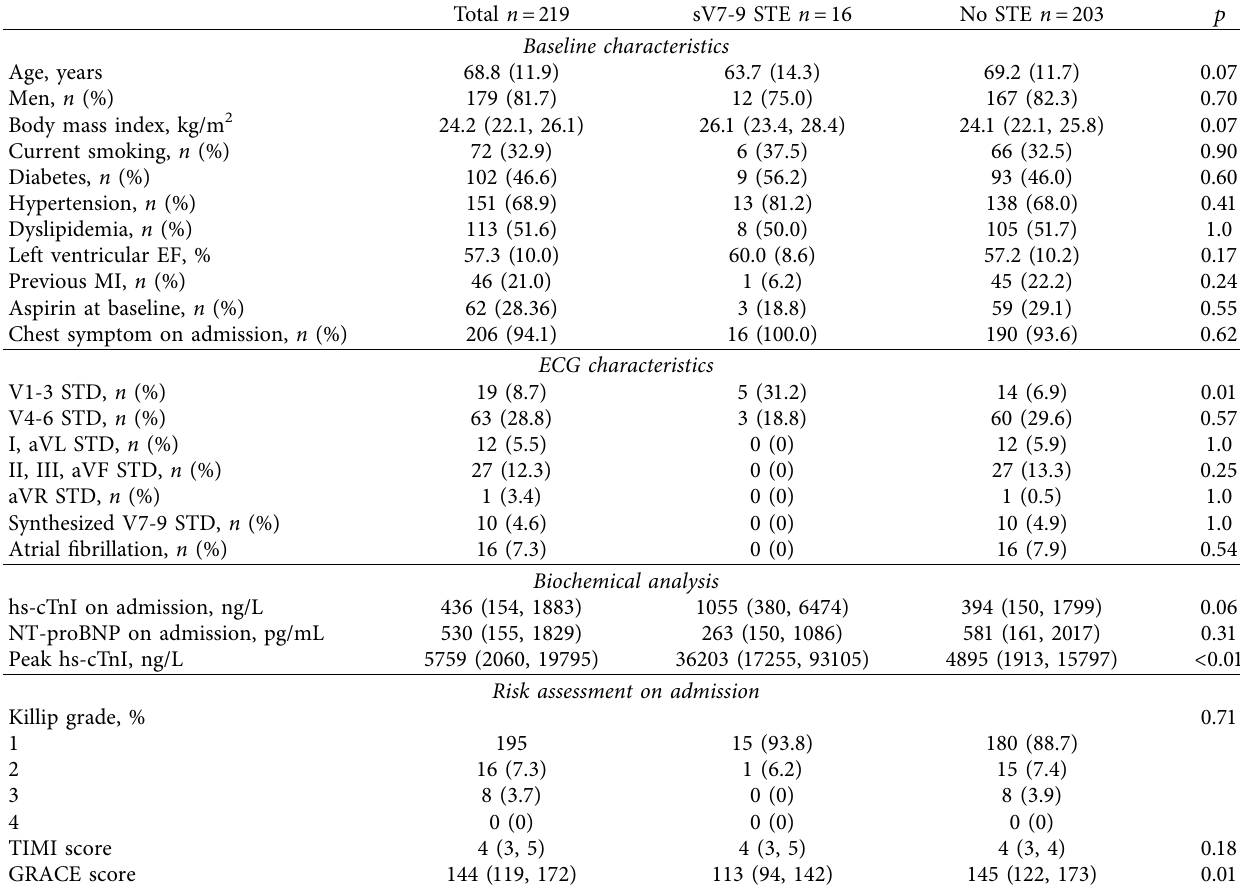
Table 1: Patient characteristics.